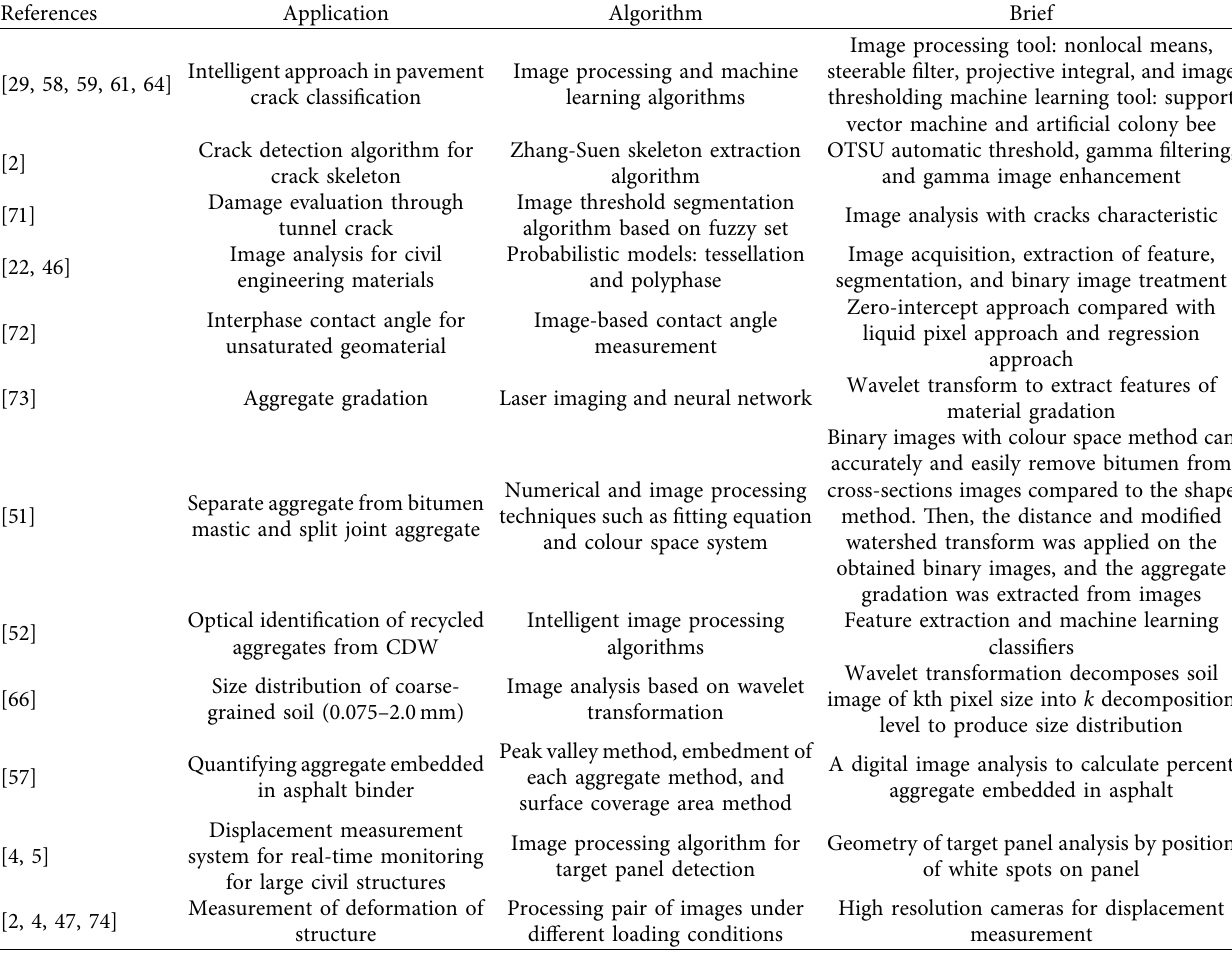
Table 2: Algorithmic analysis for civil engineering